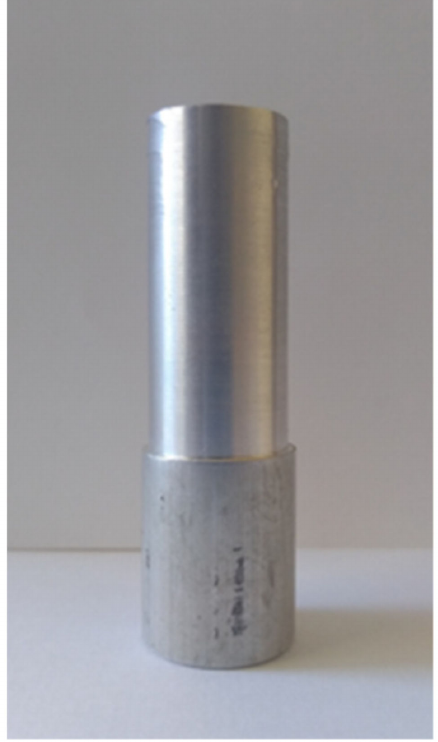
Figure 10. Turned part manufactured at the